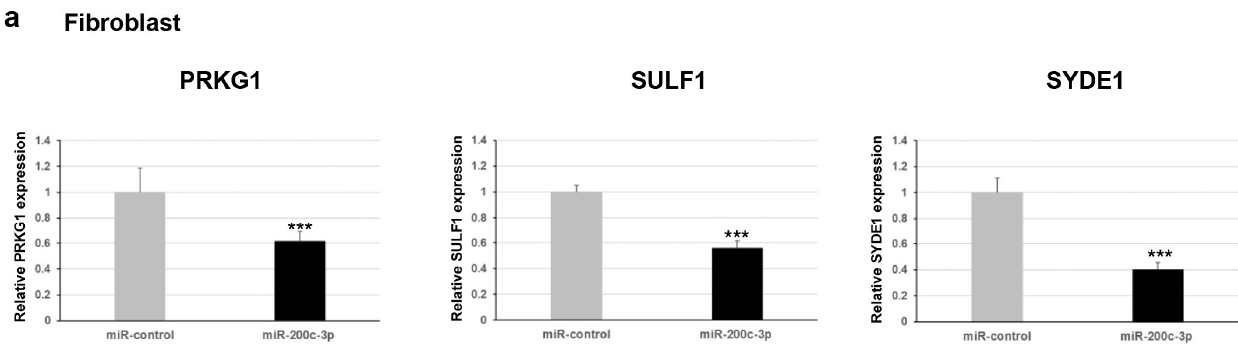
Figure 2. ( a ) Expression profile of PRKG1 , SULF1 , and SYDE1 in fibroblast (upper panel) or HEK293 cells (lower panel) transfected with hsamiR-200c-3p mimic or miR-control by quantitative PCR. Each biological replicate ( n = 3) was run in three technical replicates. Scale bars represent standard errors (** p < 0.05, *** p < 0.01). ( b ) Whole protein lysates from HEK293 transfected with hsa-miR200c- 3p or miR-control were separated on 10% SDS-gel and subjected to immunoblotting with an- tiPRKG1 and antiGAPDH antibodies. Levels of PRKG1 and GAPDH were quantified by densitom- etry using IMAGEJ analysis software. Relative PRKG1 level was normalized compared to GAPDH level. Scale bars represent standard errors (*** p < 0.01, biological replicates = 3). Wholeprotein ly- sates from HEK293 transfected with.